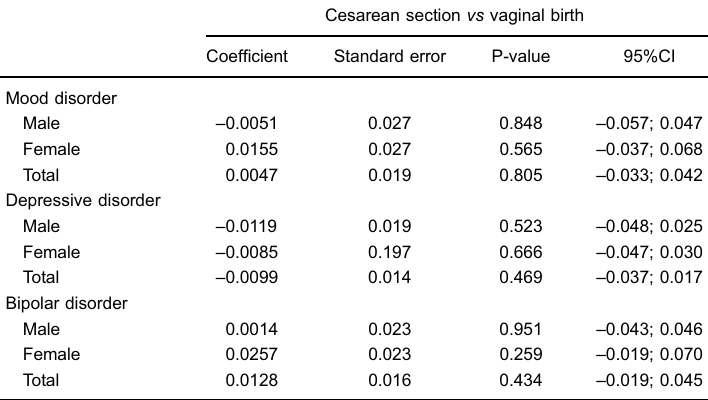
Table 4. Mean effect of cesarean section on the occurrence of mood disorders in male and female adolescents (ATE), weighted by the propensity score